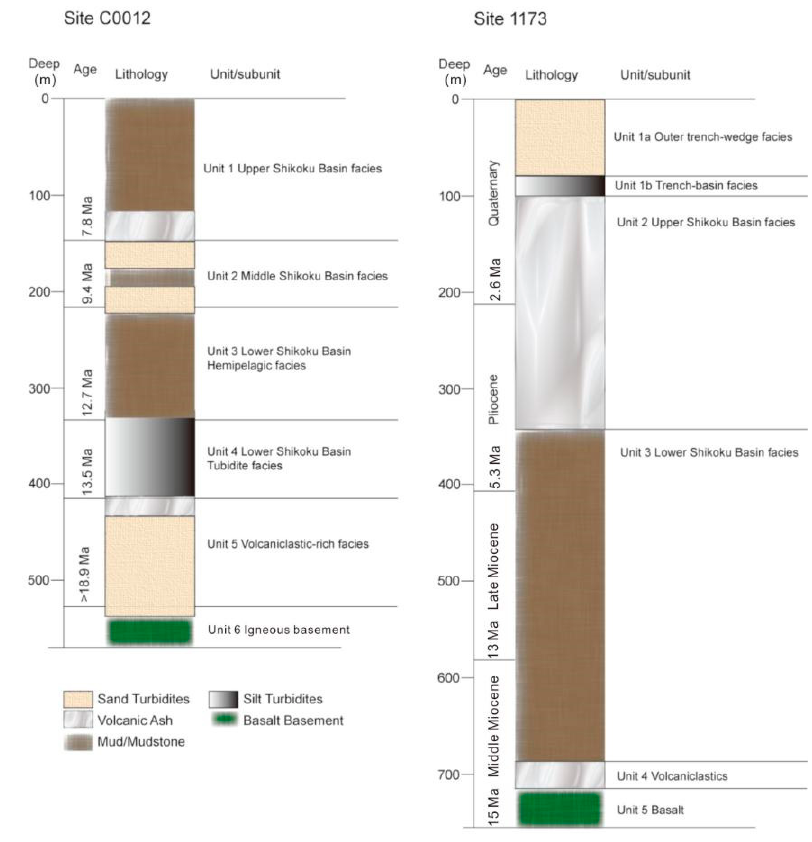
Figure 3. Stratigraphic columns for IODP Sites C0012 and 1173 drilled in the Shikoku Basin (modified after Reference [31]).